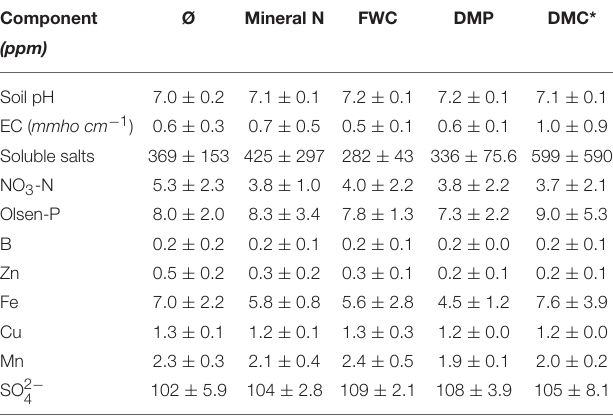
TABLE 5 | Soil chemical properties in different strips of the tomato field experiment after fertilizer application and before harvest (August 22, 2016).